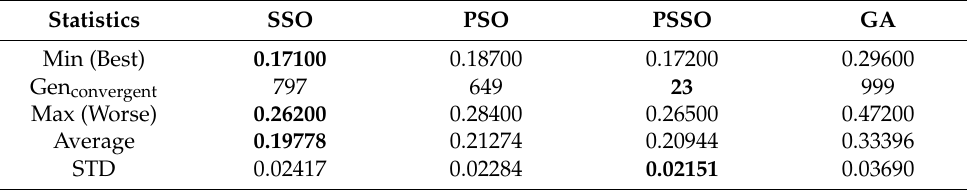
Table 5. The statistics of running time (units used: seconds) for benchmark 1.